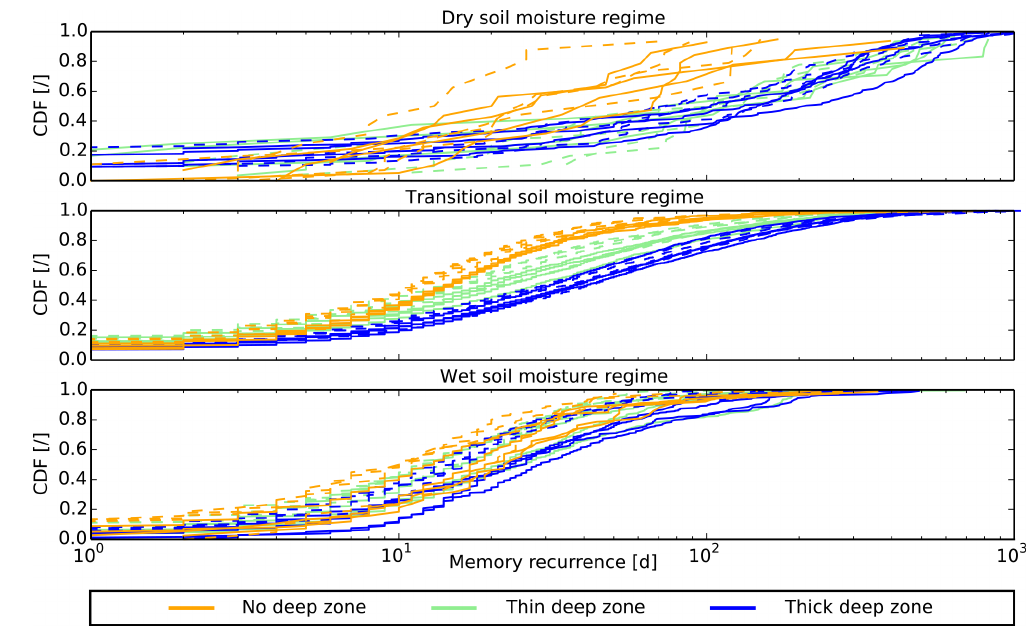
Figure 14. Normalized cumulative frequency of grid cells with recurring memory ( τ max – τ 0 ) for different soil moisture regimes (upper, middle, and lower panels). The regimes are further subdivided depending on the thickness of the deep-soil zone below the root zone (orange, green, and blue colours). Wet (dashed lines) and dry (solid lines) initial states and seasons are merged in the panels.